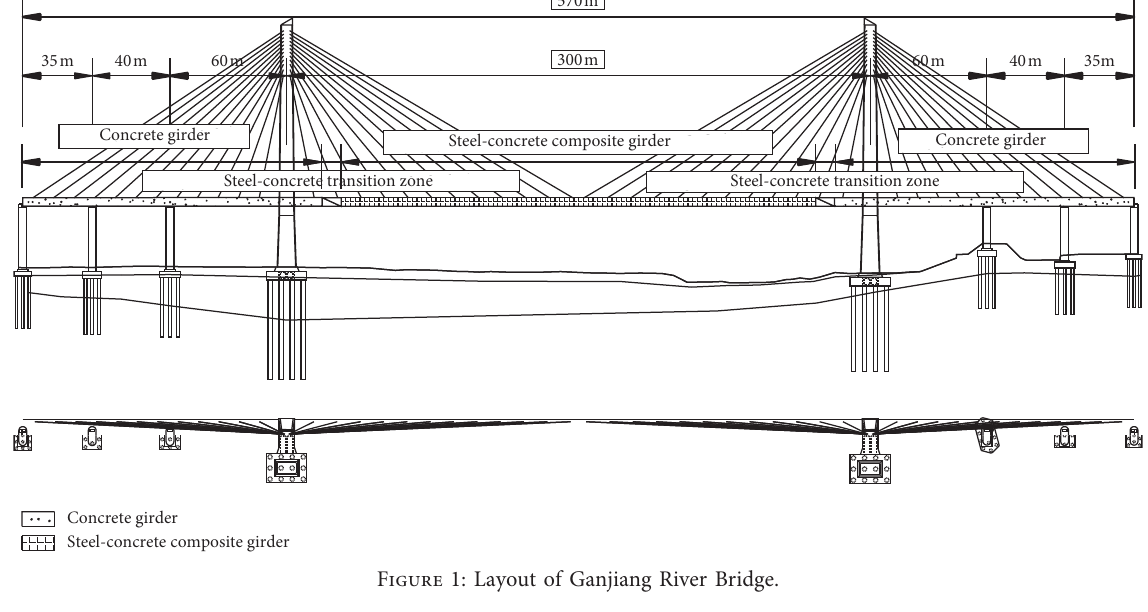
Figure 1: Layout of Ganjiang River